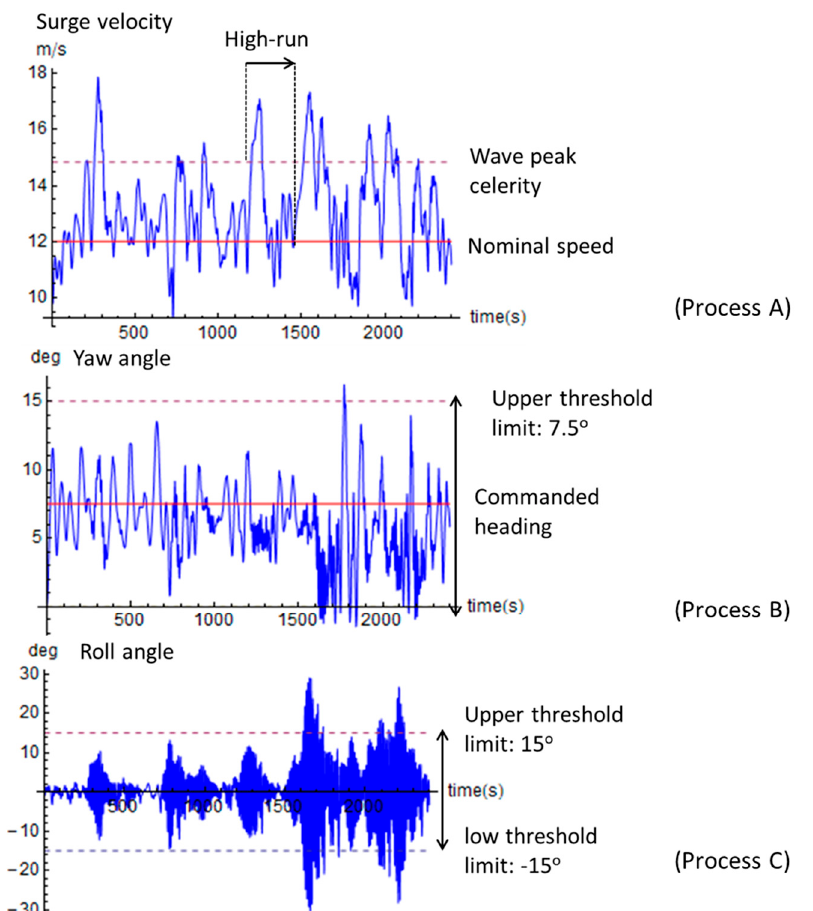
Figure 7. Definitions of the three processes which set up the ship motion exceedance problem. The upper graph shows the surge process and the associated thresholds (Process A ). Similarly, for Process B (yaw angle) in the middle graph, and for Process C (roll angle) in the lower graph.